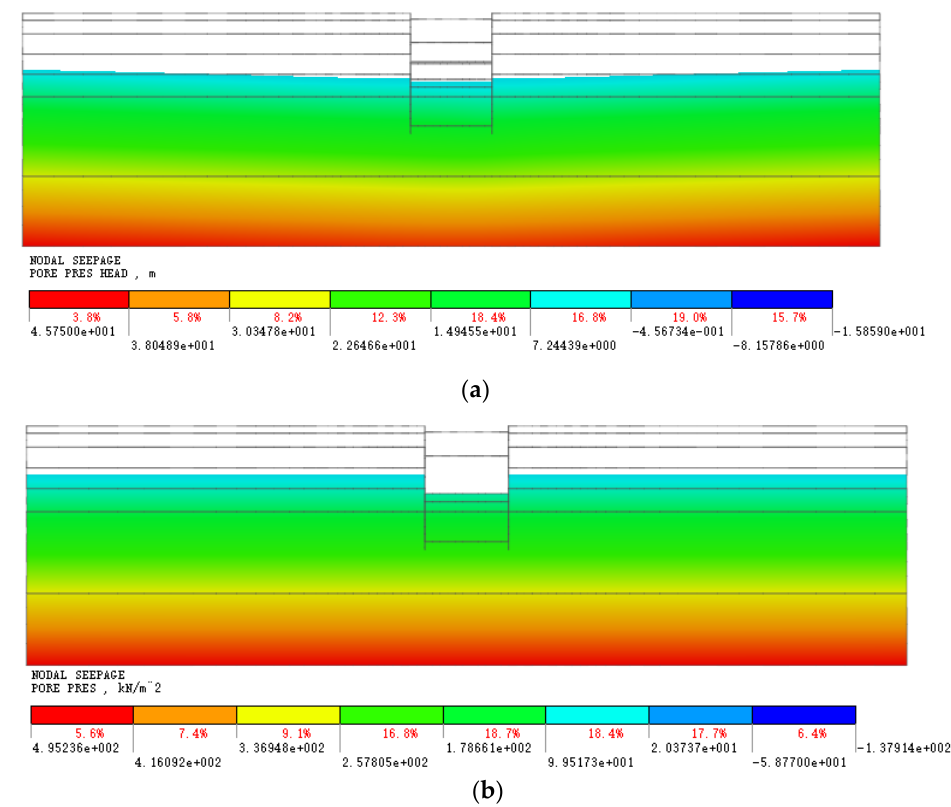
Figure 12. Total pore pressure distribution on both sides of the foundation pit before and after the rise in the water tables. ( a ) Distribution of the total pore pressure before the rise in the water rise; ( b ) Distribution of the total pore pressure after the rise in the water tables.